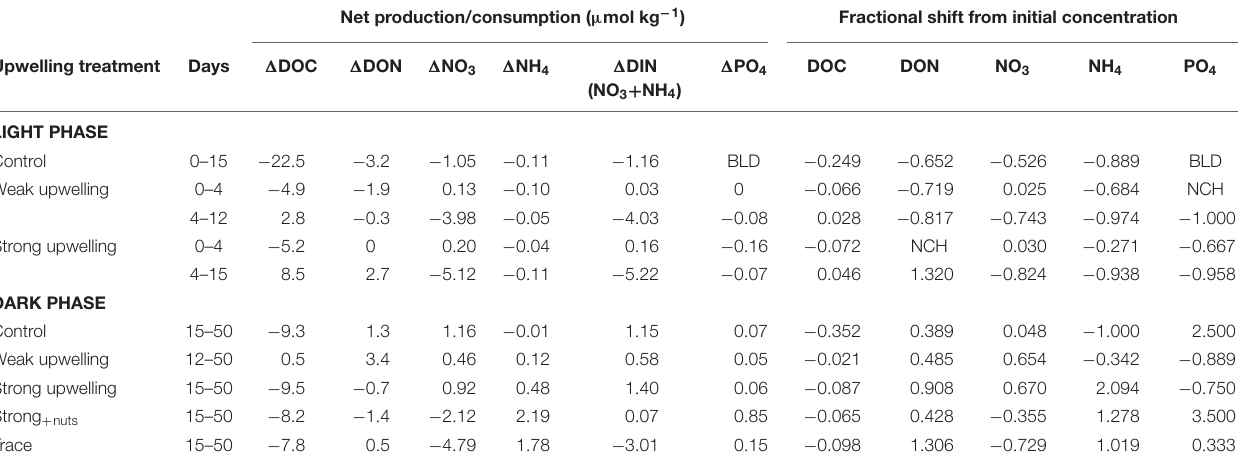
TABLE 1 | Net change of variables for the given periods and fractional shift in relation to initial concentrations. Net production/consumption ( µ mol kg − 1 ) Fractional shift from initial